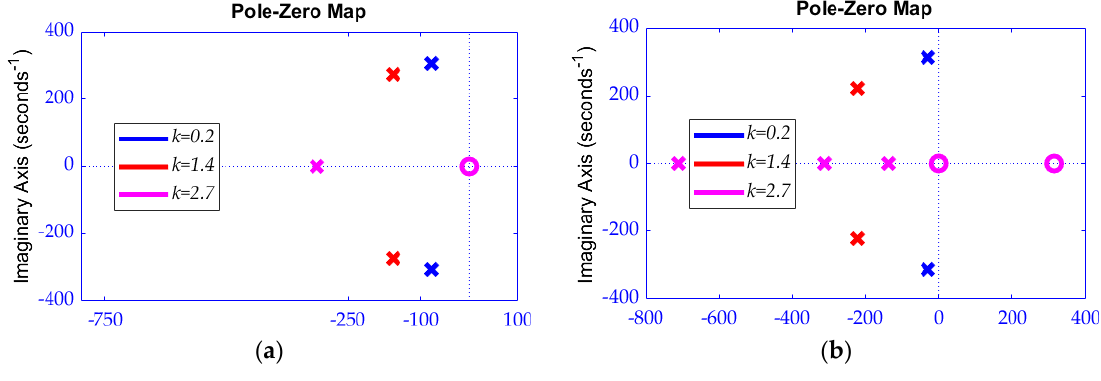
Figure 7. Pole-zero maps of MSTOGI: